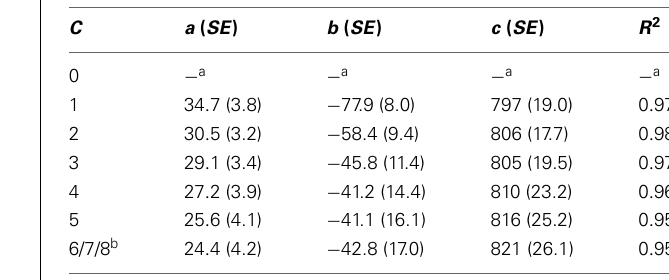
Table 4 | Summary of eight separate regression analyses predicting RT in Experiment 2 for the various